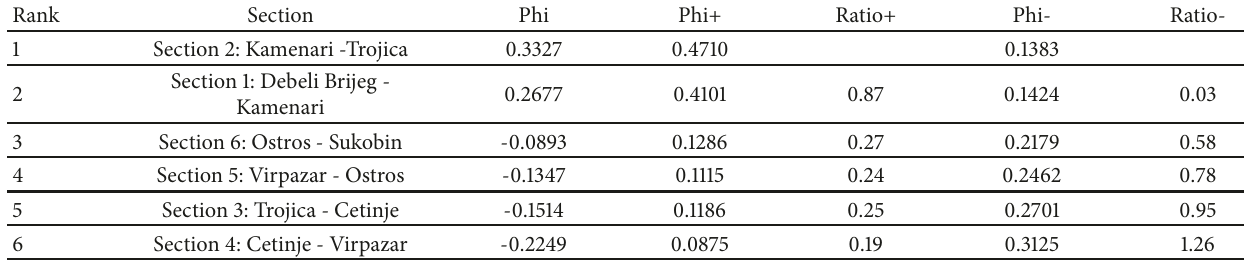
Table 5: Ranking of the sections using PROMETHEE method.